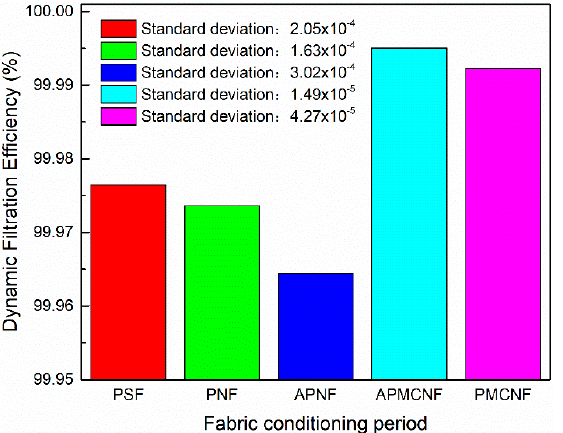
Figure 13. The dynamic filtration efficiencies of the five filter media during the fabric conditioning period.